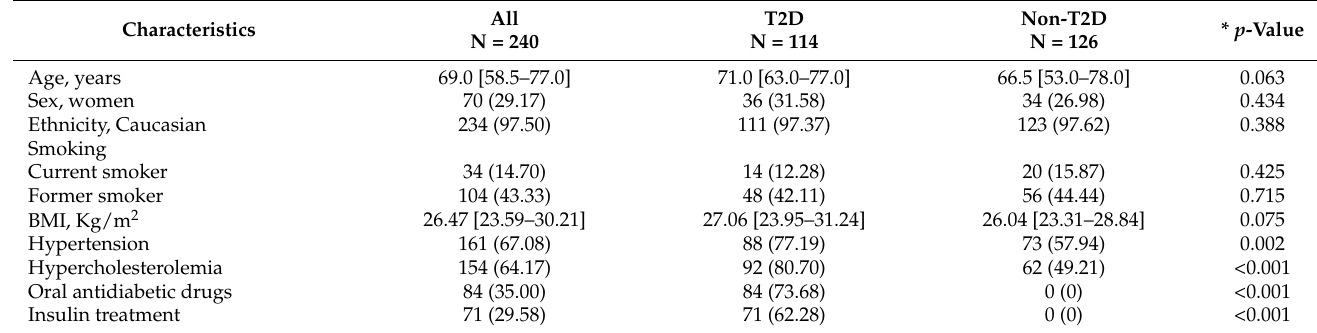
Table 1. Clinical characteristics of the study